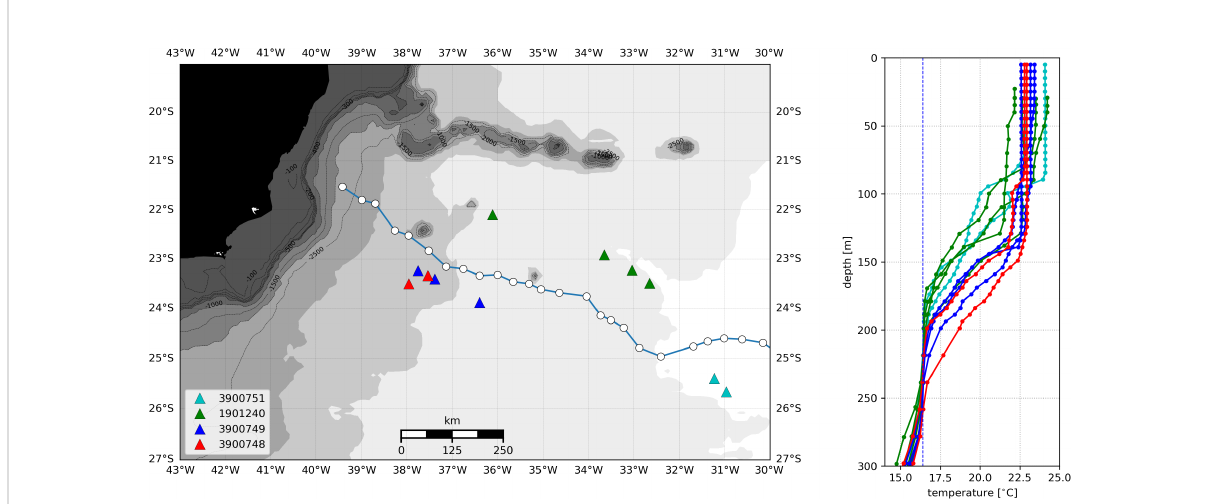
FIGURE 11 Trajectory of the sea level anomaly related to the Ring Eliza between 30°W and the Brazilian coast at 39°W (18-May-2010 through 02-Nov- 2010). Left: Triangles mark the positions of the Argo fl oats that sampled the Type I mode water within a radius of 150 km from the center of the feature. The bottom topography is shown in the background in gray. Right: Temperature pro fi les measured by the Argo fl oats. The vertical dashed blue line marks the thermostad temperature at